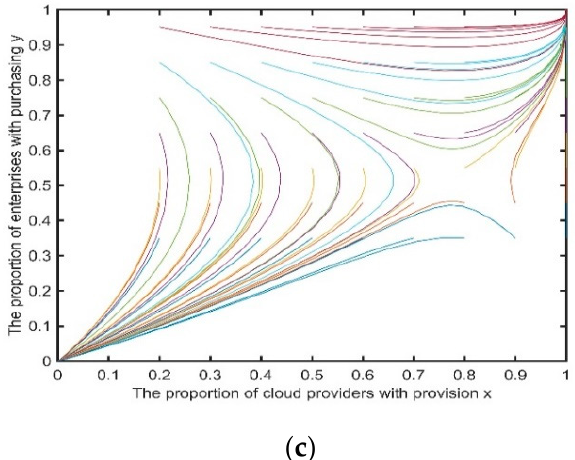
Figure 4. The relationship between Ⅱ S and ESS. Figure 4. ( a – c ) The relationship between S II and